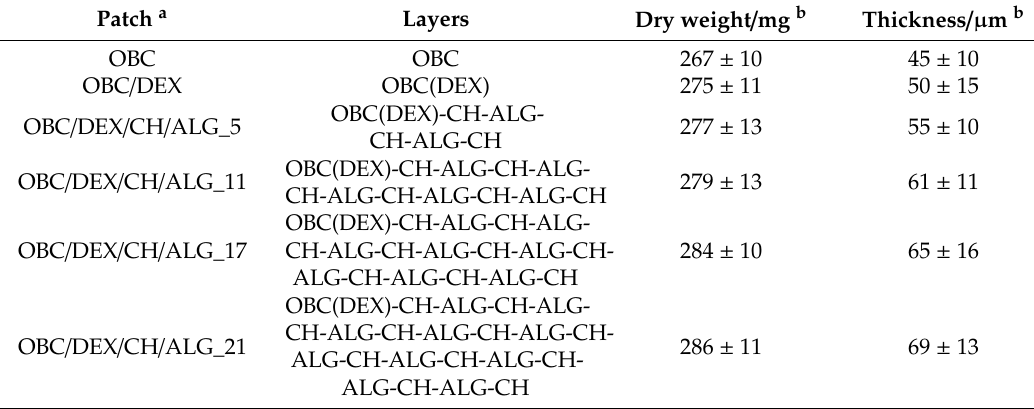
Table 1. List of patches with the respective dry weight and thickness